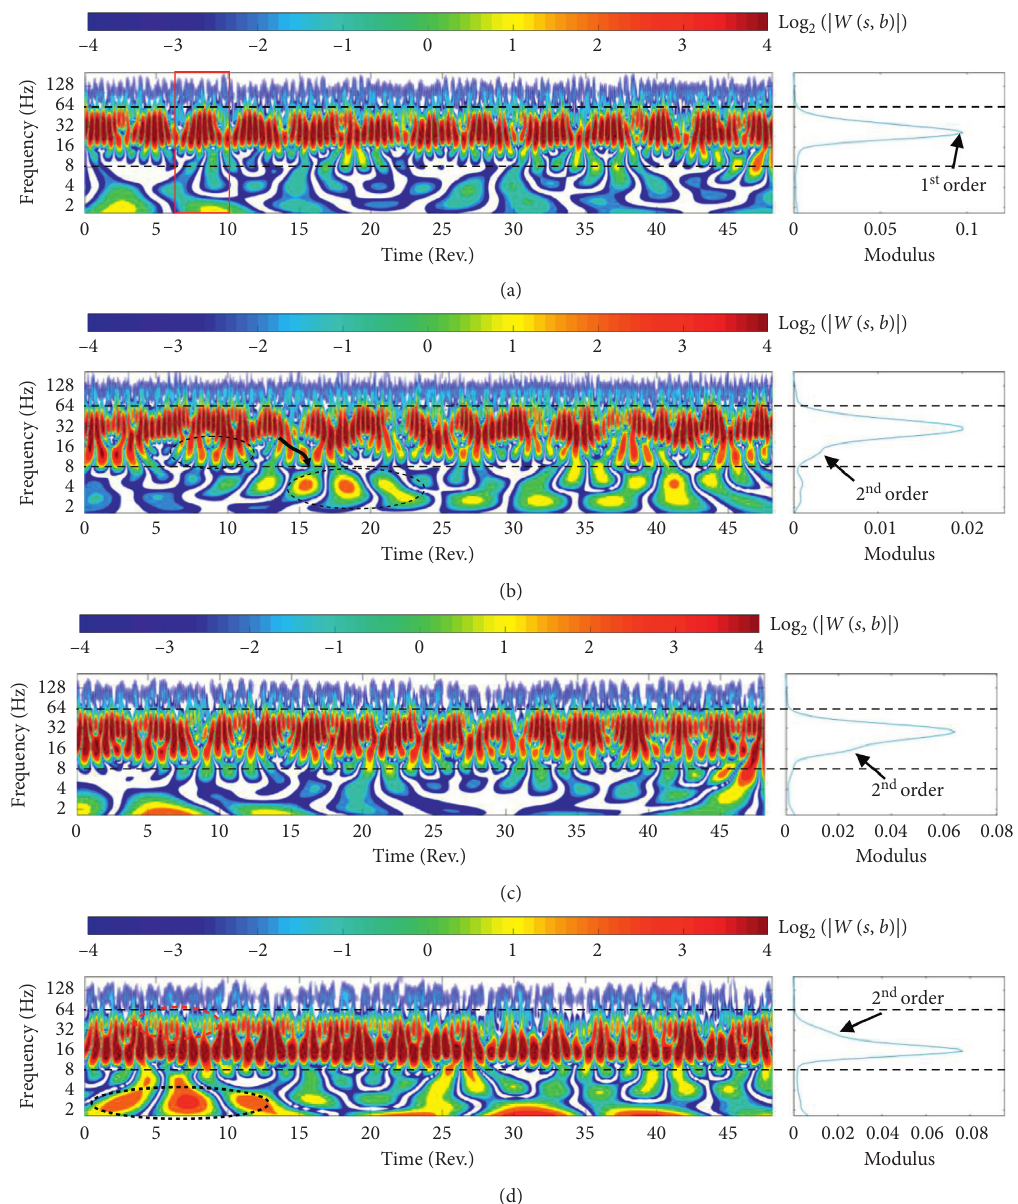
Figure 7: Wavelet modulus spectrum of pressure pulsation at impeller inlet with different tip clearances. (a) t � 0.2mm. (b) t � 0.5mm. (c) t � 0.8 mm. (d) t � 1.1